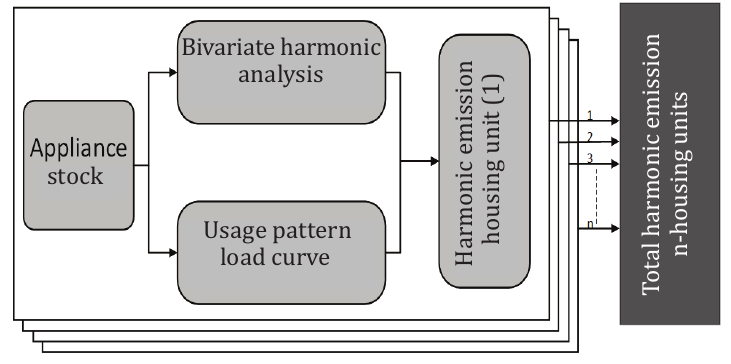
Fig. 8. Harmonic current estimation of multiple ho